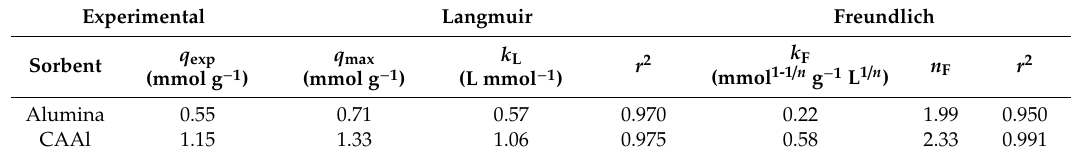
Figure 5. Equilibrium studies for zinc removal using alumina and CAAl materials as sorbents (pH 0 : 4, Table 2. Langmuir and Freundlich parameters of the sorbents for zinc removal.